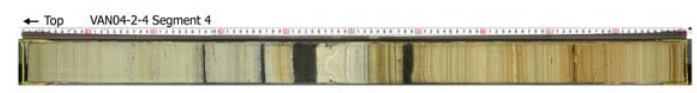
Figure 3. Core photo from core Site 2 obtained in 2004 (VAN04-2-4, segment 4) with annually laminated lacustrine sediments and intercalated tephra